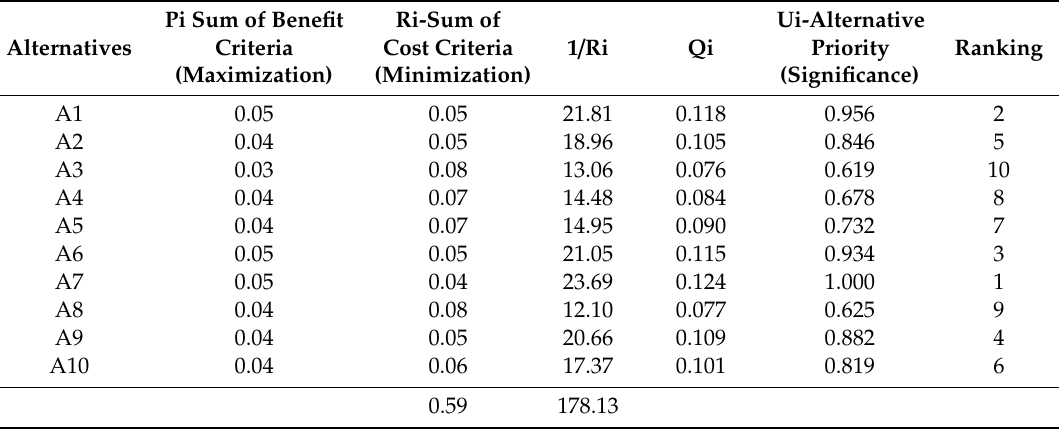
Table 9. Complex proportional fuzzy assessment (COPRAS-F) calculations and ranking of